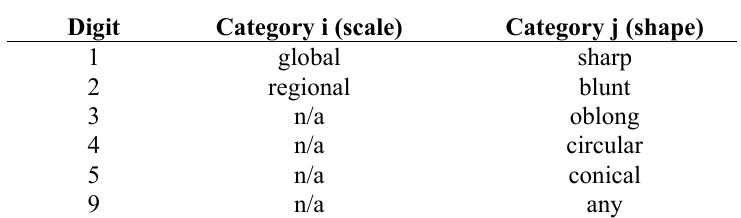
Table 2. Digits that determine the categories (i) and (j) of a peak scale and shape. The category (j) = 9 comprises (any) undefined